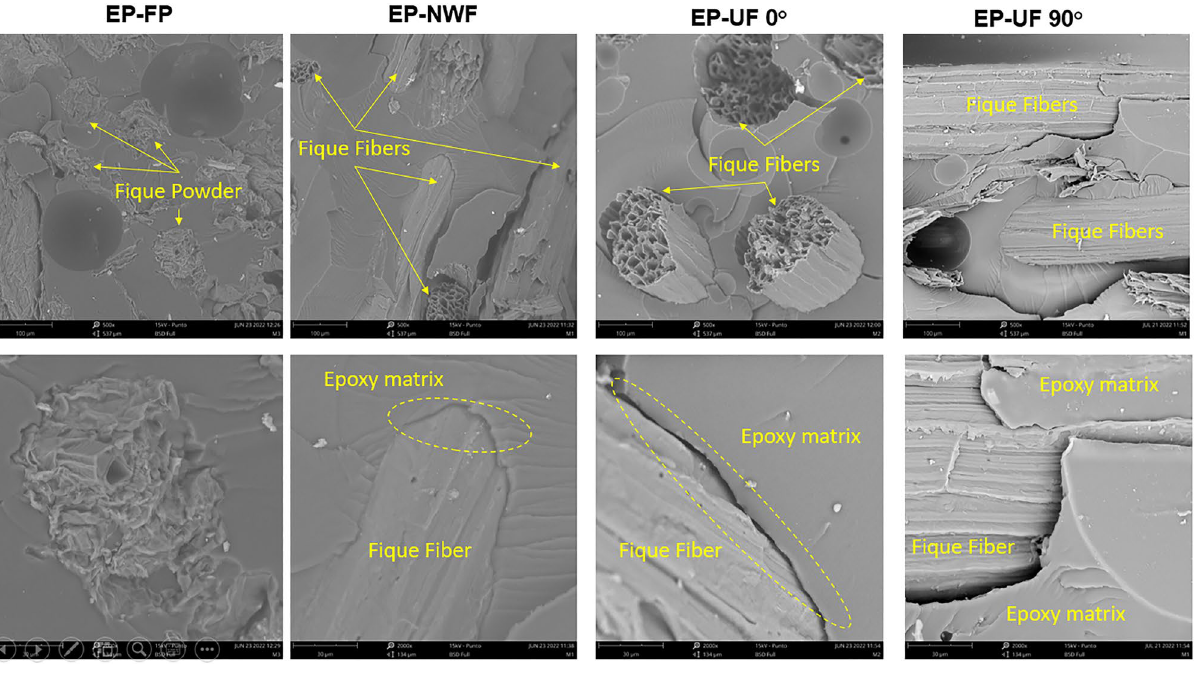
Figure 10. SEM micrographs of the cross-sectional area of EP-fique biocomposites.